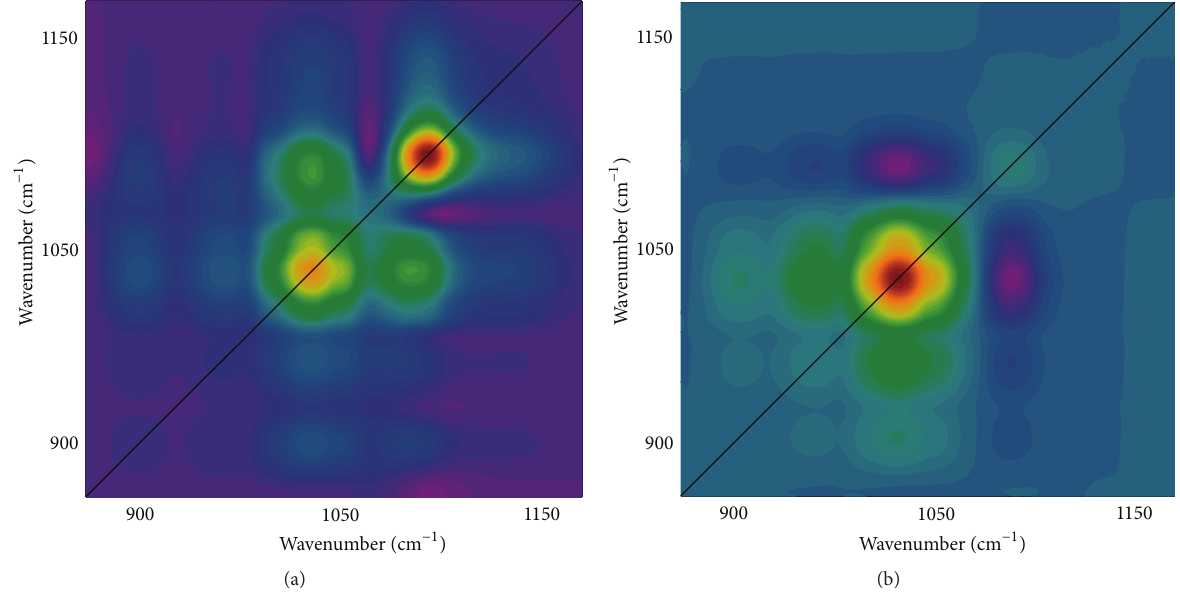
Figure 4: ATR-FTIR synchronous 2D correlation spectrum of (a) control and (b) RMF exposed BC samples. The degree of correlation is visualized with the rainbow color map. The cold colors represent negative correlation, and the warm colors represent positive